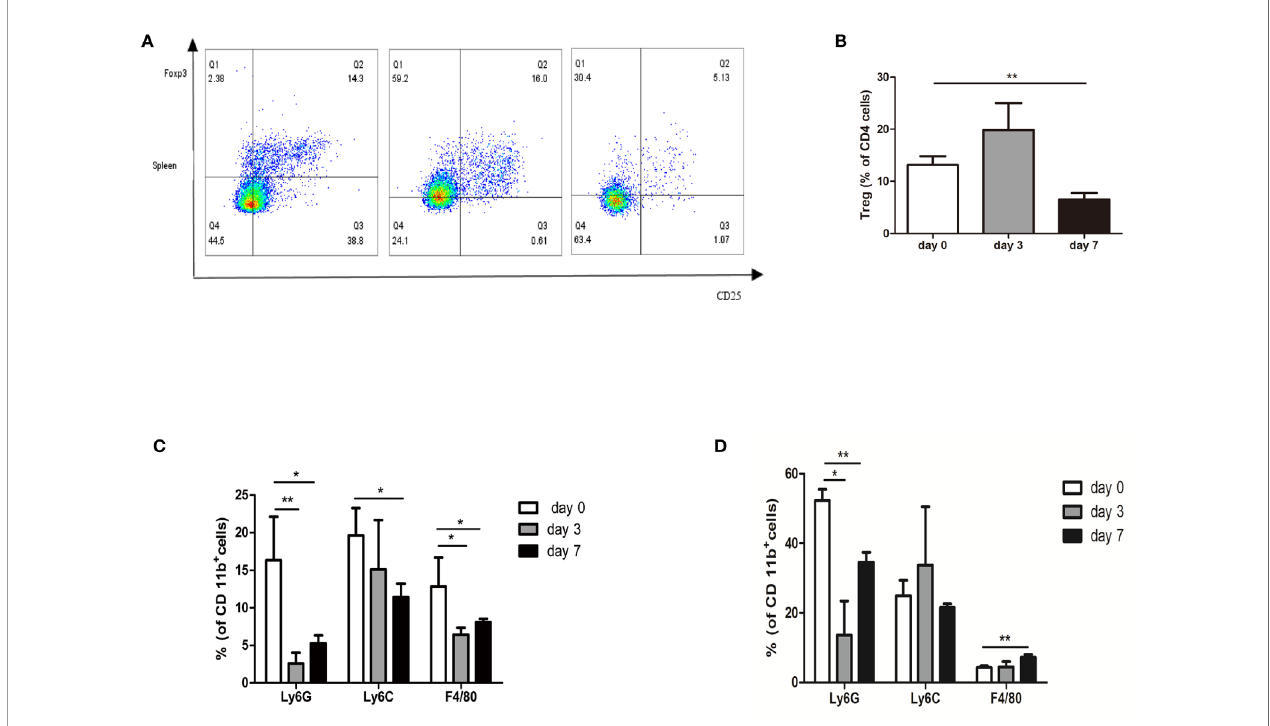
FIGURE 6 | Pro fi ling of immune suppressive cells after nsPEFs treatment. (A) Frequency of Treg cells in response to nsPEFs treatment in the spleen on day 3 and 7. Analyses were performed on CD4 + cells. (B) Frequency of MDSCs (CD11b + Ly6G + and CD11b + Ly6C + ) and macrophages (CD11b + F4/80 + ) in the tumor on day 3 and 7. (C) Frequency of MDSC (CD11b + Ly6G + and CD11b + Ly6C + ) and macrophages (CD11b + F4/80 + ) in the spleen on day 3 and 7. (D) Frequency of MDSC (CD11b + Ly6G + and CD11b + Ly6C + ) and macrophages (CD11b + F4/80 + ) in the tumor on day 3 and 7. Data are presented as the mean ± SD. P-values were calculated based on a Student ’ s t -test (n = 4 per group). * p < 0.05, ** p <